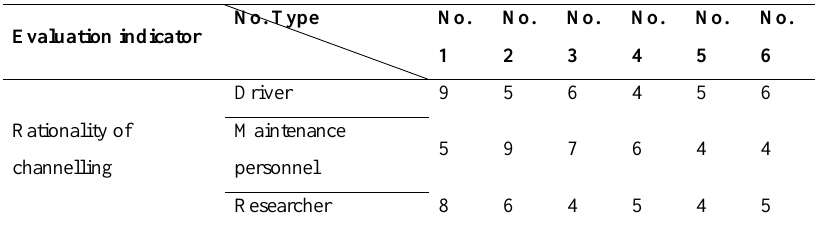
Table 5 Deduction of test